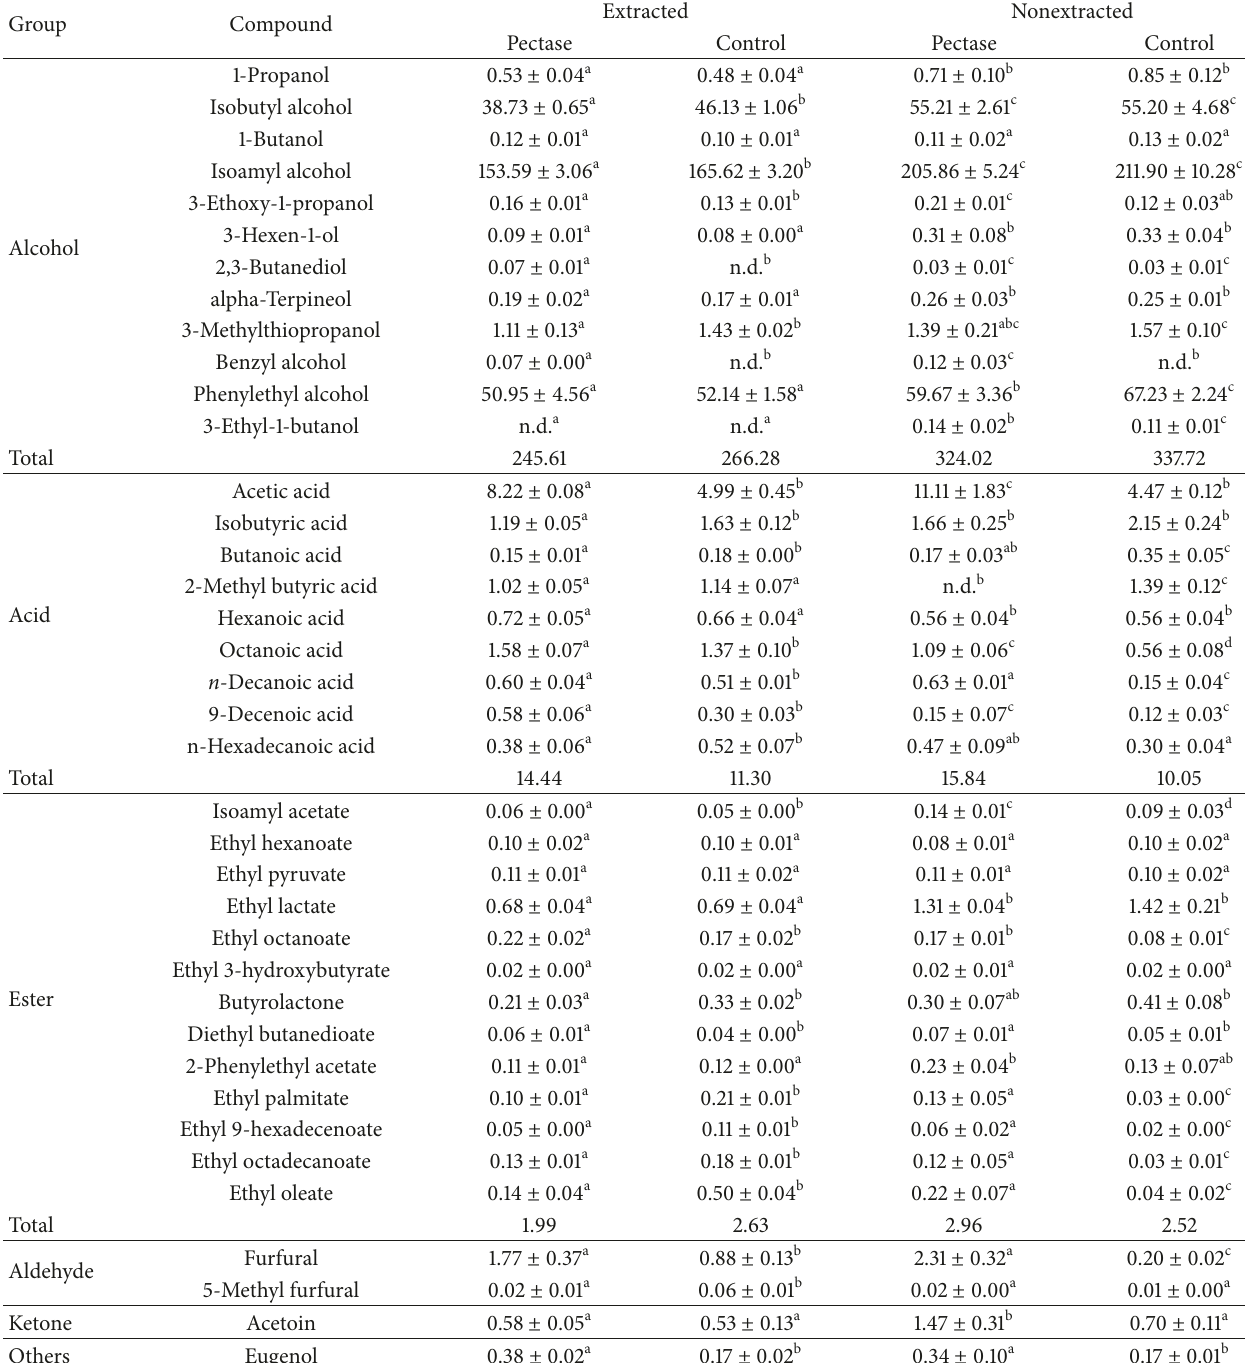
Table 2: Major volatiles ( 𝜇 g/g) for extracted and nonextracted wine, with and without pectase treatment. Group